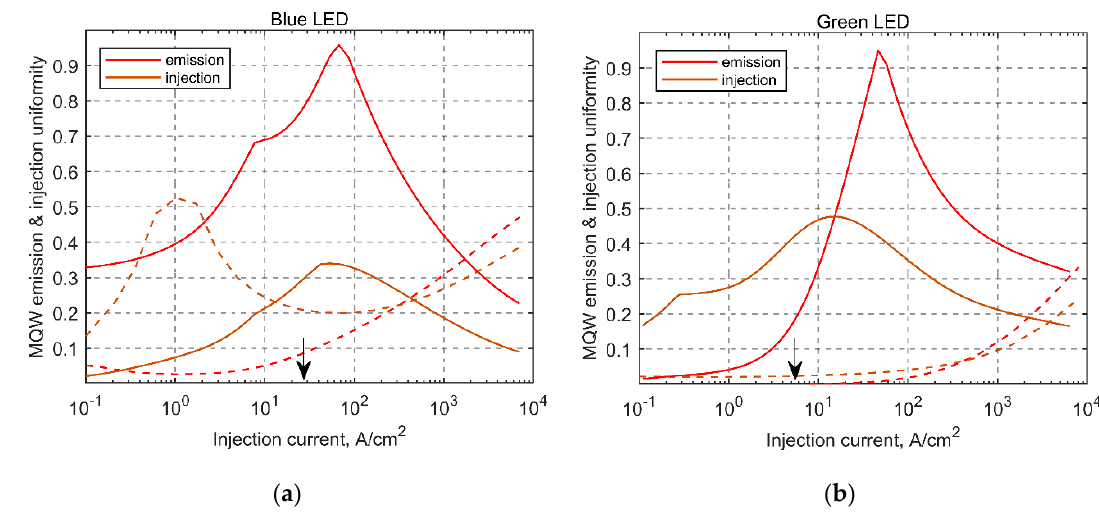
Figure 4. Injection dependence of MQW active region emission and injection uniformity characteristics in ( a ) blue-emitting and ( b ) green-emitting LEDs with plain-barrier (dashed lines) and optimized IBL (solid lines) active region design. Arrows indicate the LED injection levels corresponding to maximum external quantum efficiency (EQE). Table 2. IBL characteristics in simulated structures.